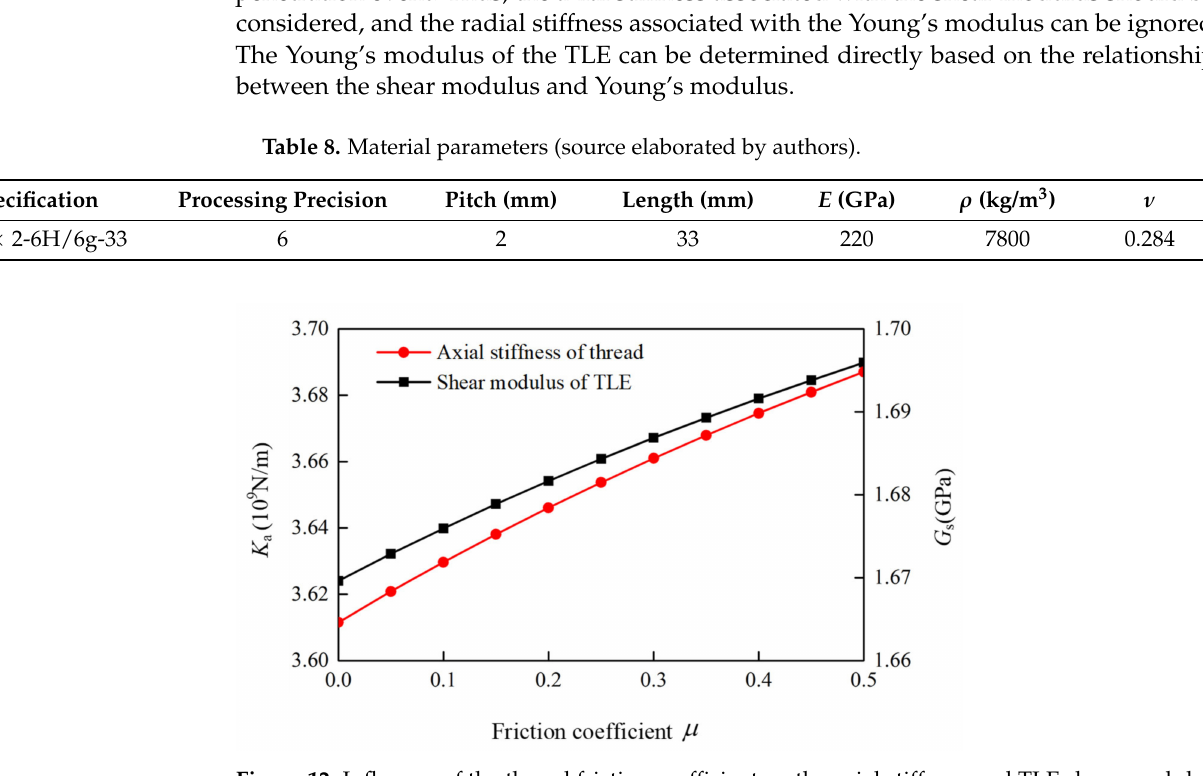
Figure 12. Influence of the thread friction coefficient on the axial stiffness and TLE shear modulus (source elaborated by authors). Table 9. Threaded axial stiffness and material parameters of the TLE (source elaborated by